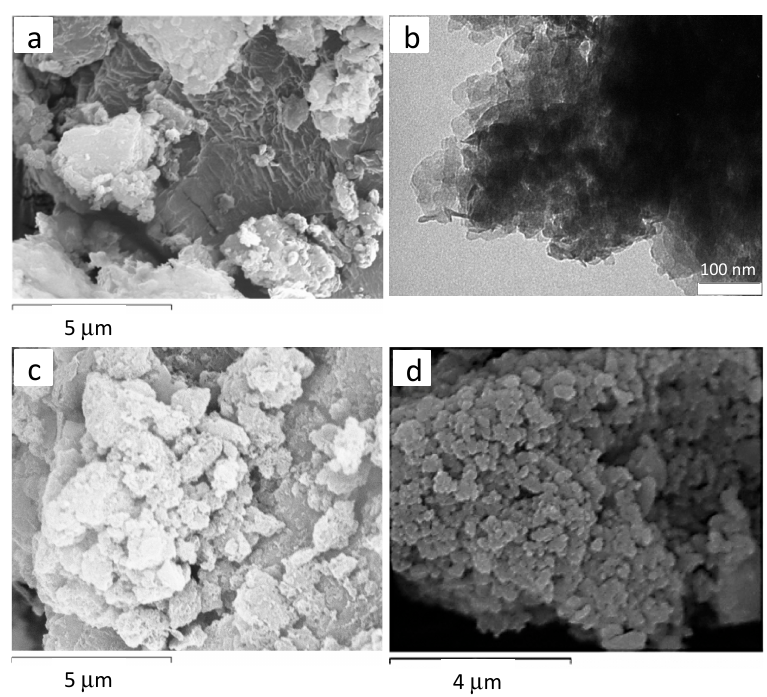
Figure 5. Several representative micrographs of the hydrotalcite-type compounds: ( a ) SEM of HTMgAl1, ( b ) TEM of HTMgAl3, ( c ) SEM of HTNiMgAl1, and ( d ) SEM of HTCuZnCr.